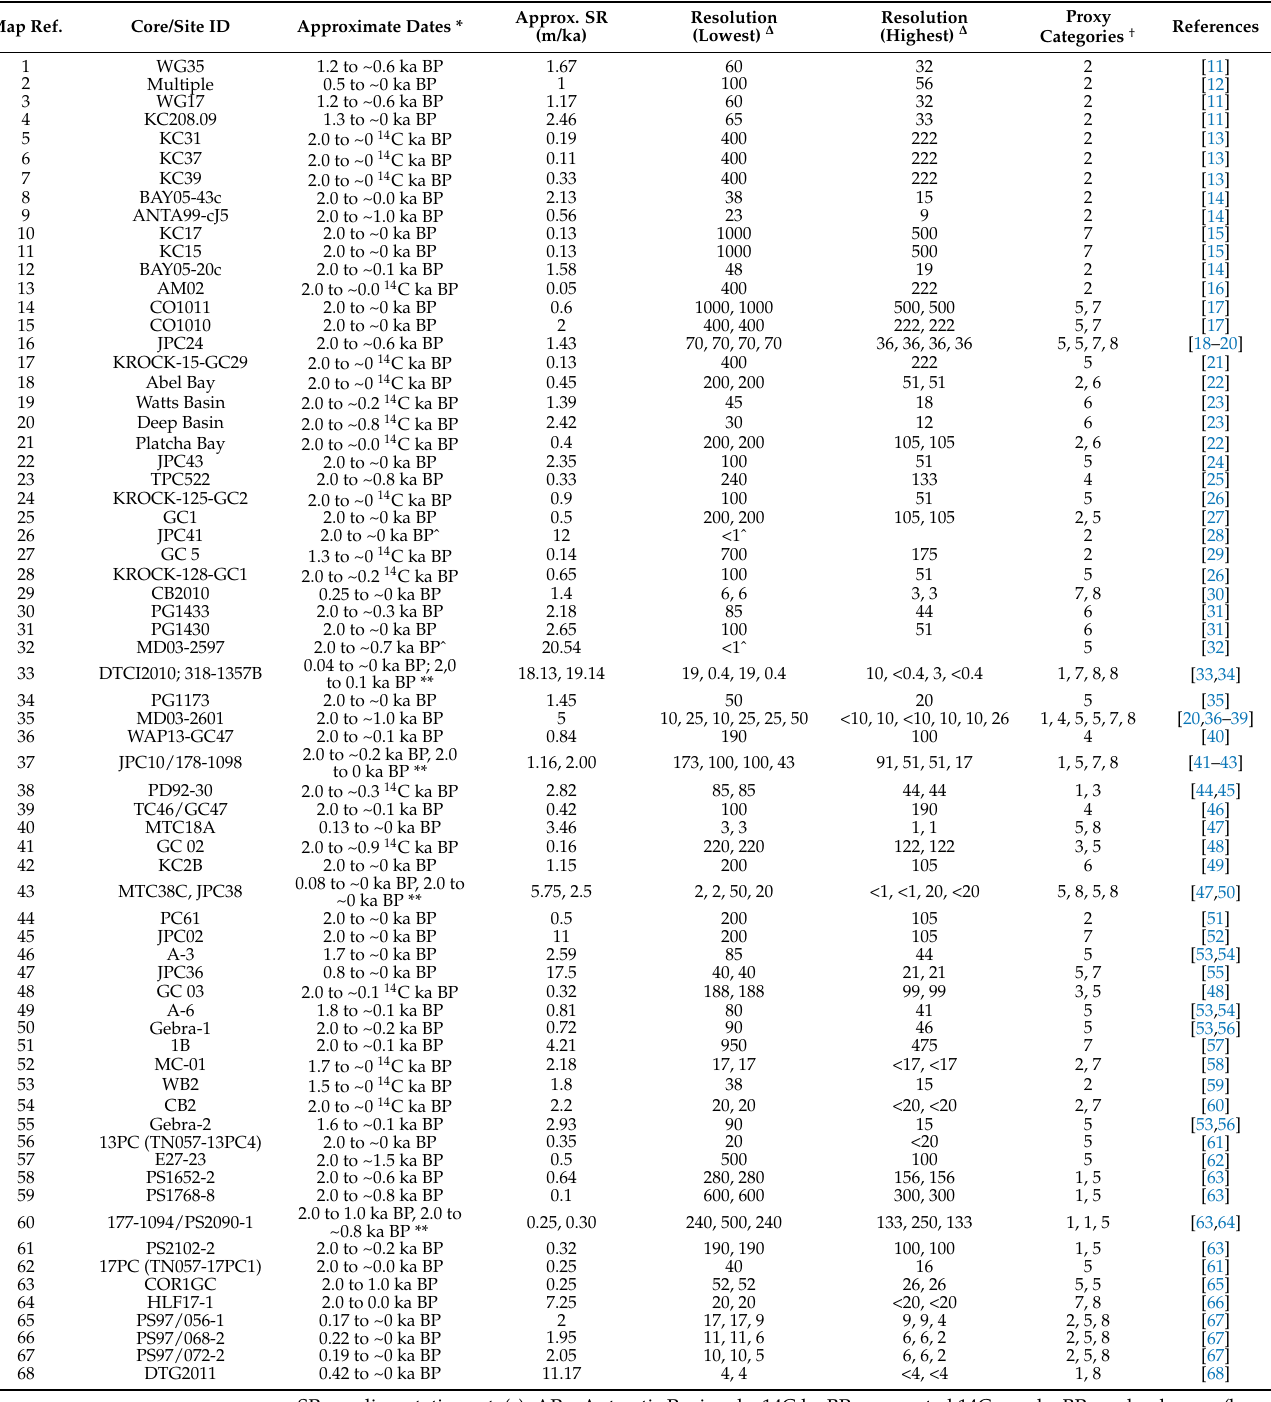
Table 4. Summary information on the ages, resolution and proxy types of all sites. Map